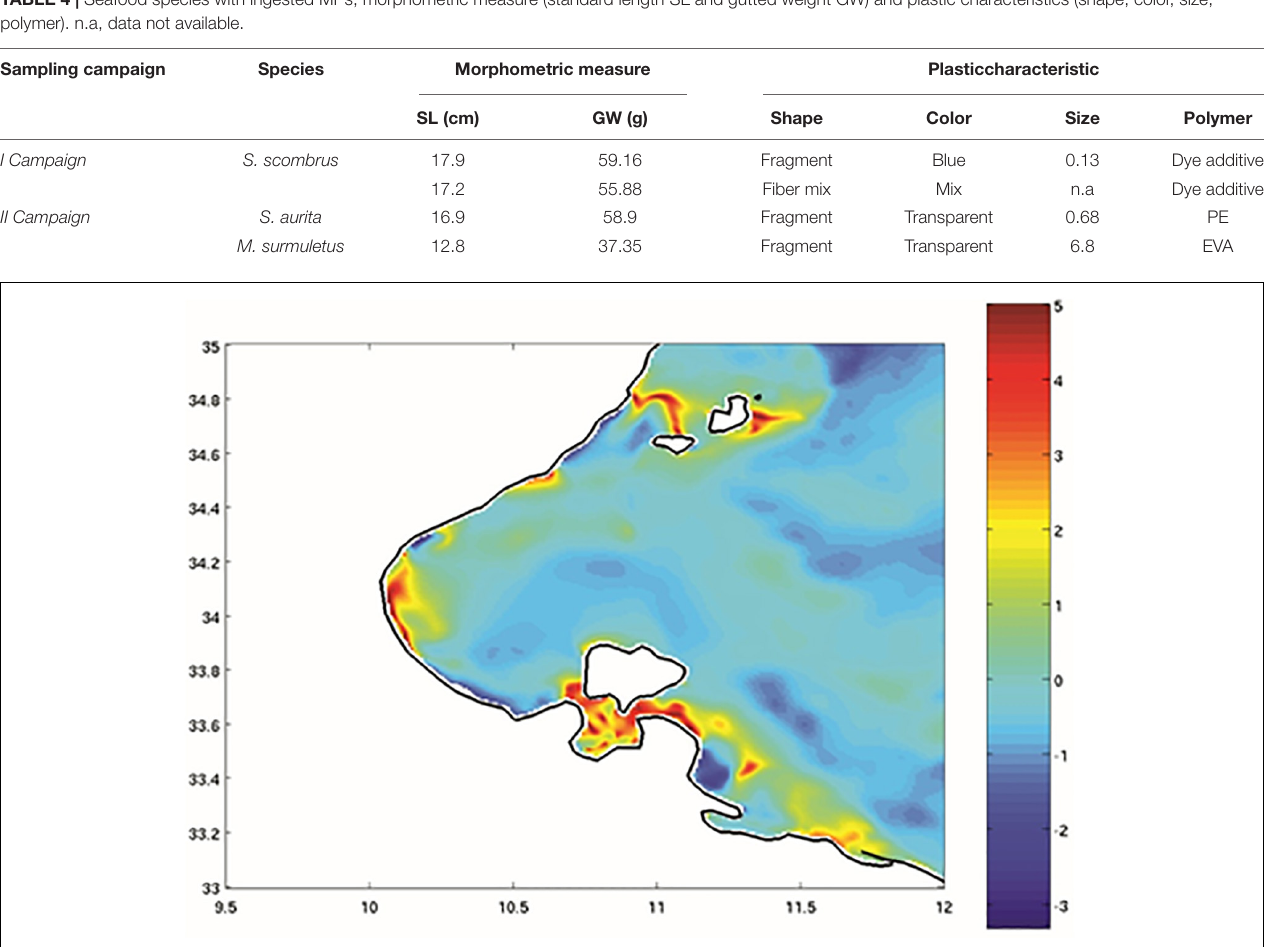
FIGURE 3 | The logarithmic of the ratio between EKE over MKE on the annual scale.